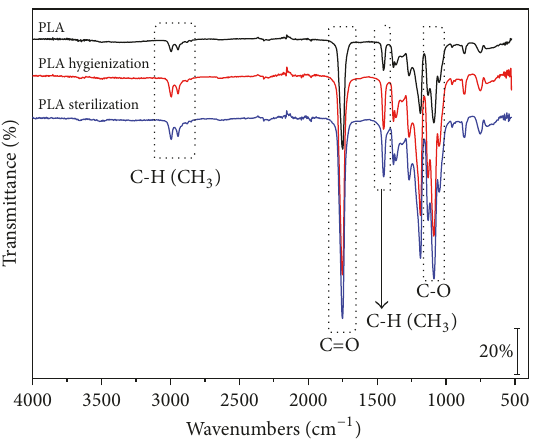
Figure 1: FTIR of PLA before and after the hygienization and sterilization process.